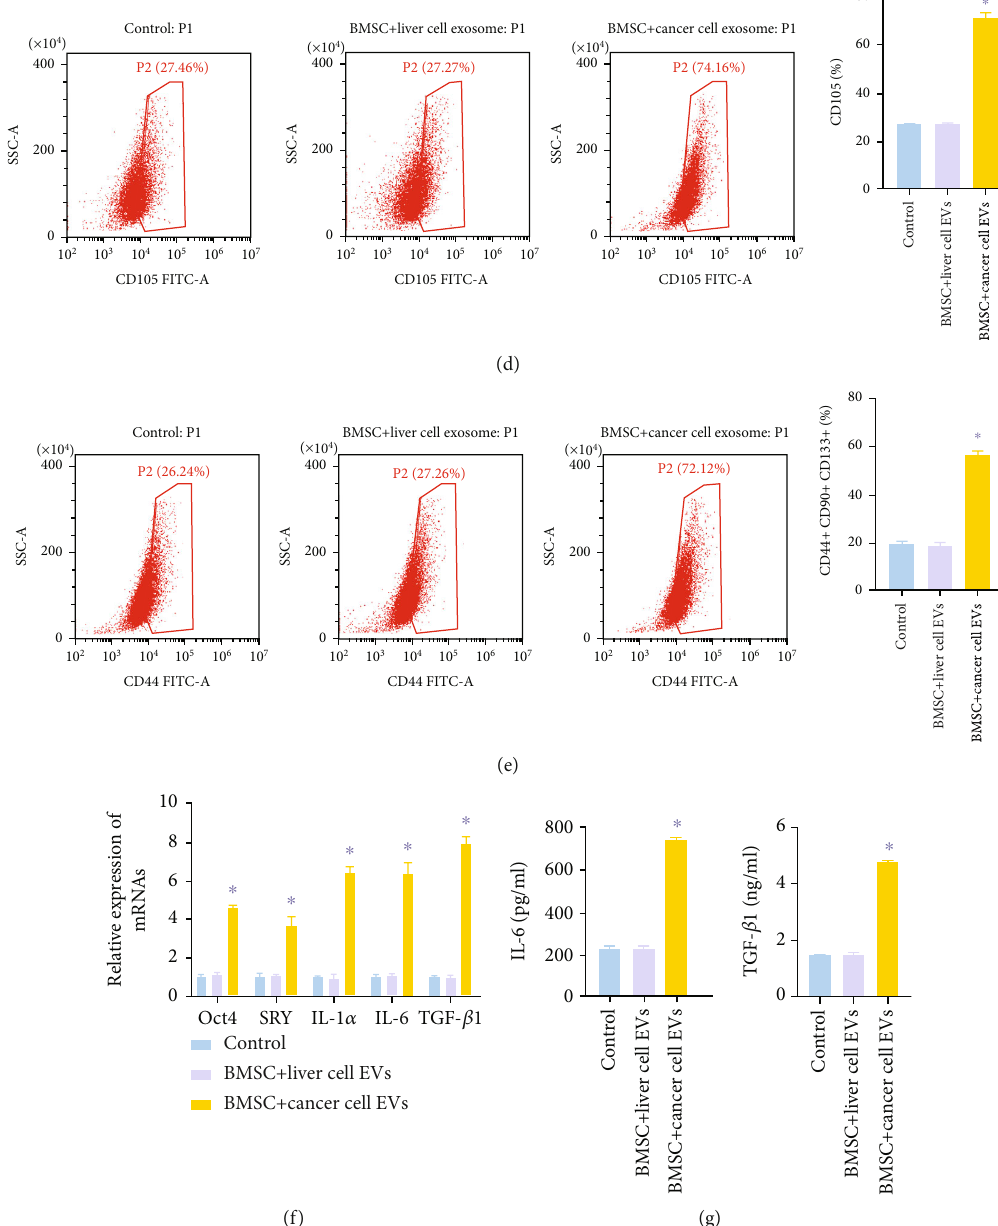
Figure 3: EVs promoted the di ff erentiation of BMSCs into cancer stem cells. EVs derived from tumor or normal tissues were cocultured with BMSCs for 48 h. Then, (a) the EV uptake was observed by IF staining. Scale bar: 100 μ m. 100x magni fi cation. (b) Flow cytometry was performed to test the ratio of CD44 in BMSCs. (c) Flow cytometry assessed the ratio of CD31 in BMSCs. (d) Flow cytometry tested the ratio of CD105 in BMSCs. (e) Flow cytometry assessed the ratio of CD44+ CD90+ CD133+ cells in BMSCs. (f) RT-qPCR evaluated Oct4, SRY, IL-1 α , IL-6, and TGF- β 1 levels in BMSCs. (g) ELISA was performed to test the content of IL-6 and TGF- β 1 in supernatants of BMSCs. ∗ P < 0 : 05 compared to the control. ns indicated no signi fi cant